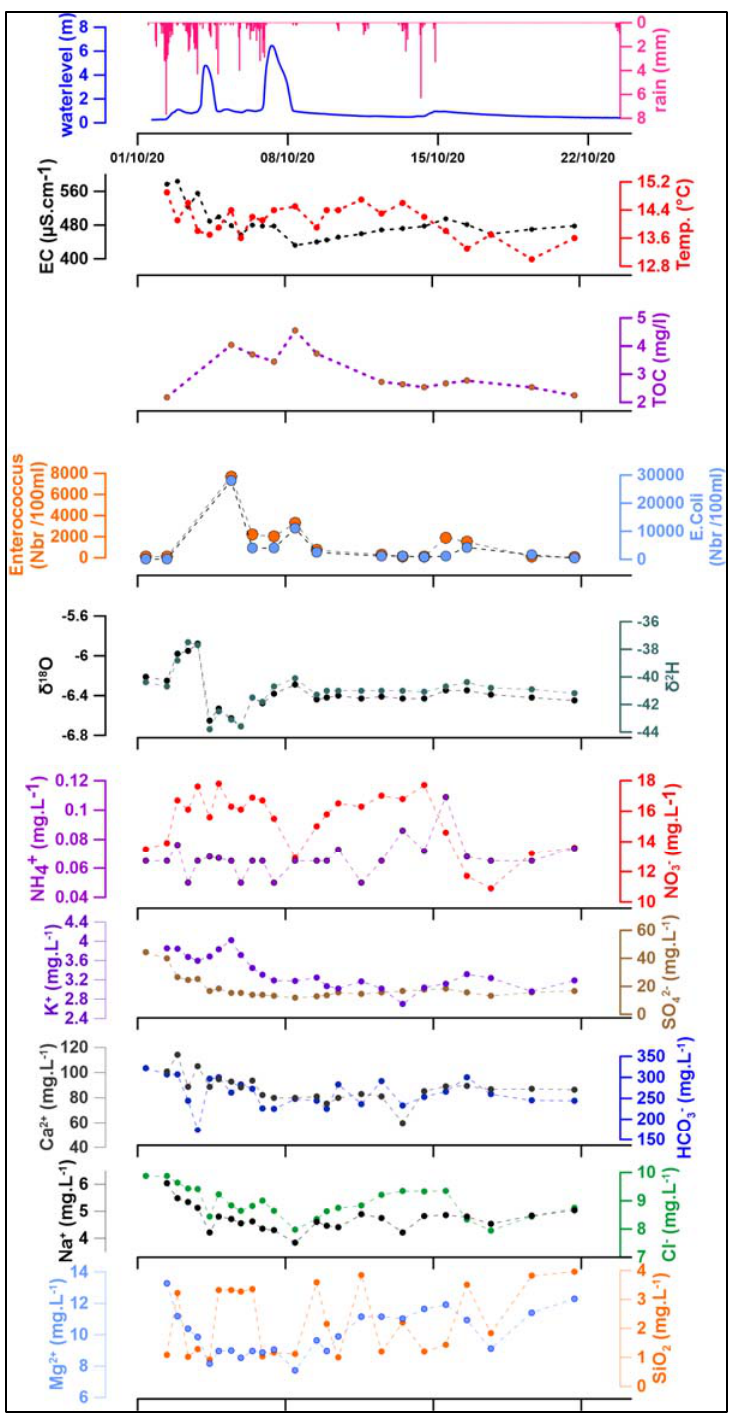
Figure B3. Chemiograph of the Courtilles borehole from 20/09/20 to 21/10/20. Figure A6. Chemiograph of the Courtilles borehole from 20/09/20 to